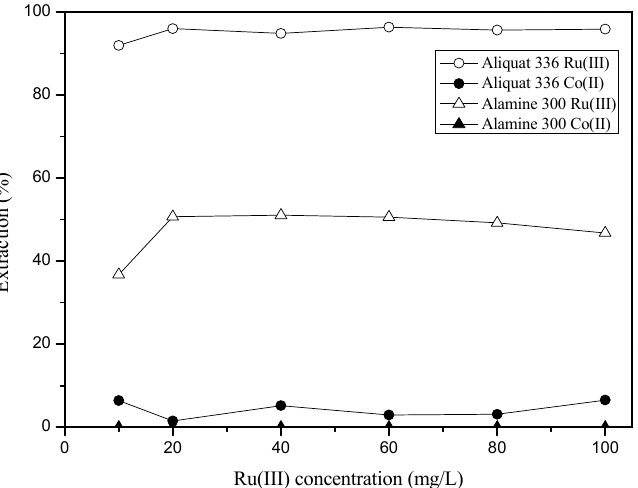
Figure 2. Effect of Ru(III) concentration on the separation of Co(II) from 3 M HCl solution. ([Extractant] = 0.1 M and [Co(II)] = 100 mg/L).